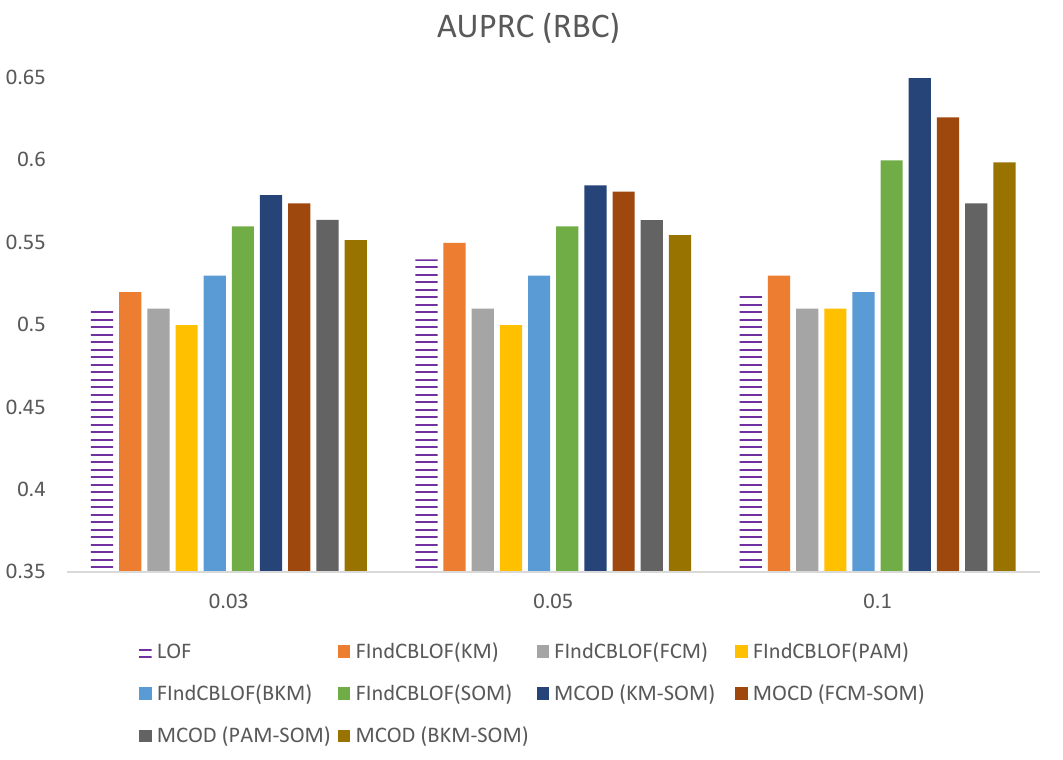
Figure 3. Detection Accuracy (RBC Dataset).